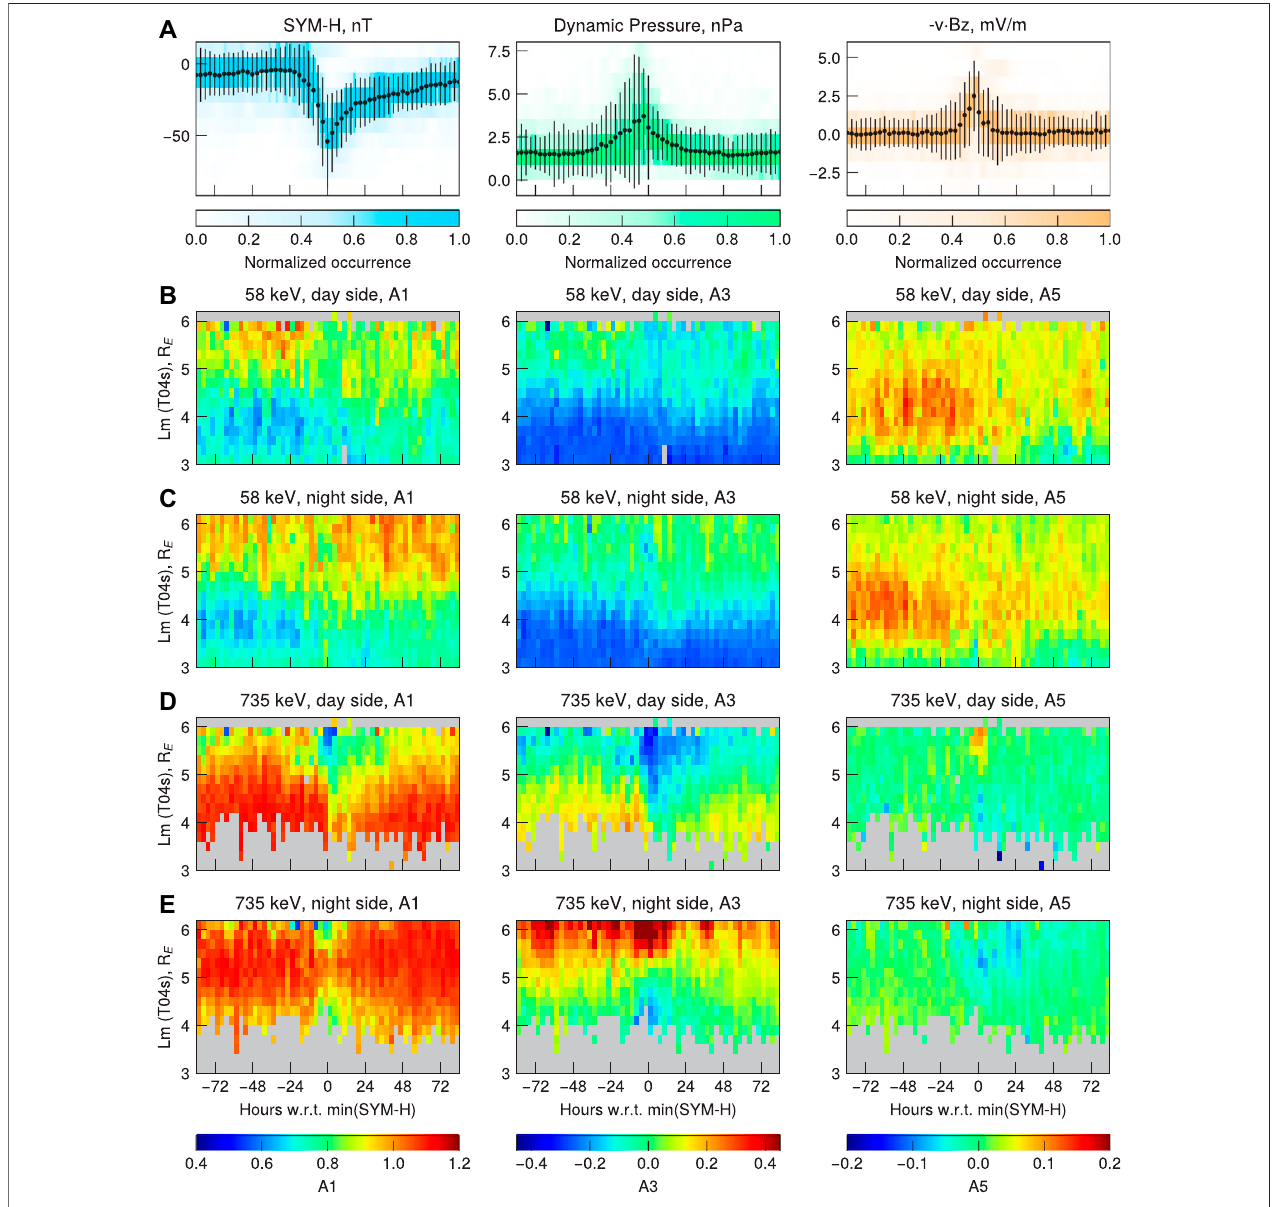
FIGURE 3 | (A) SYM-H index, SW dynamic pressure and electric fi eld superposed for 129 storms in 2012 – 2019, (B) 3-h averaged dayside values of the A1 (pancake), A3(butter fl y)and A5(cap)coef fi cients for58 keVelectrons,binnedbytheepochs(with respecttotheSYM-Hindex minimum)andLm.The coef fi cients inthe same format for nightside evolution of 58 keV coef fi cients is shown in row (C) . The storm-time evolution of the 735 keV electron PADs for day- and nightside is given in rows (D) and (E) ,